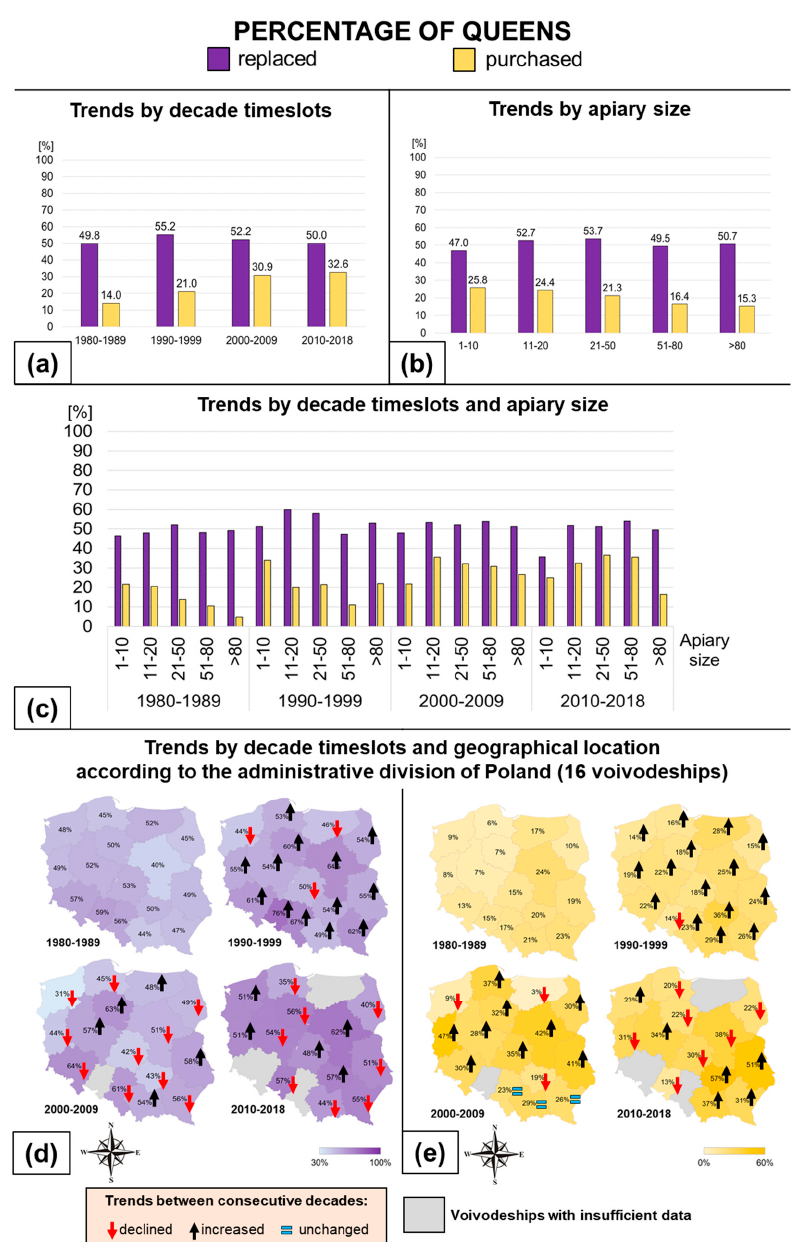
Figure 2. Percentage of replaced queens, and percentage of purchased queens in regard only to colonies in which queens were replaced: ( a ) trends by decade timeslot; ( b ) trends by apiary size; ( c ) trends by decade timeslot and apiary size; ( d ) trends by decade timeslot and geographical location for replaced queens; and ( e ) trends by decade timeslot and geographical location for purchased queens.